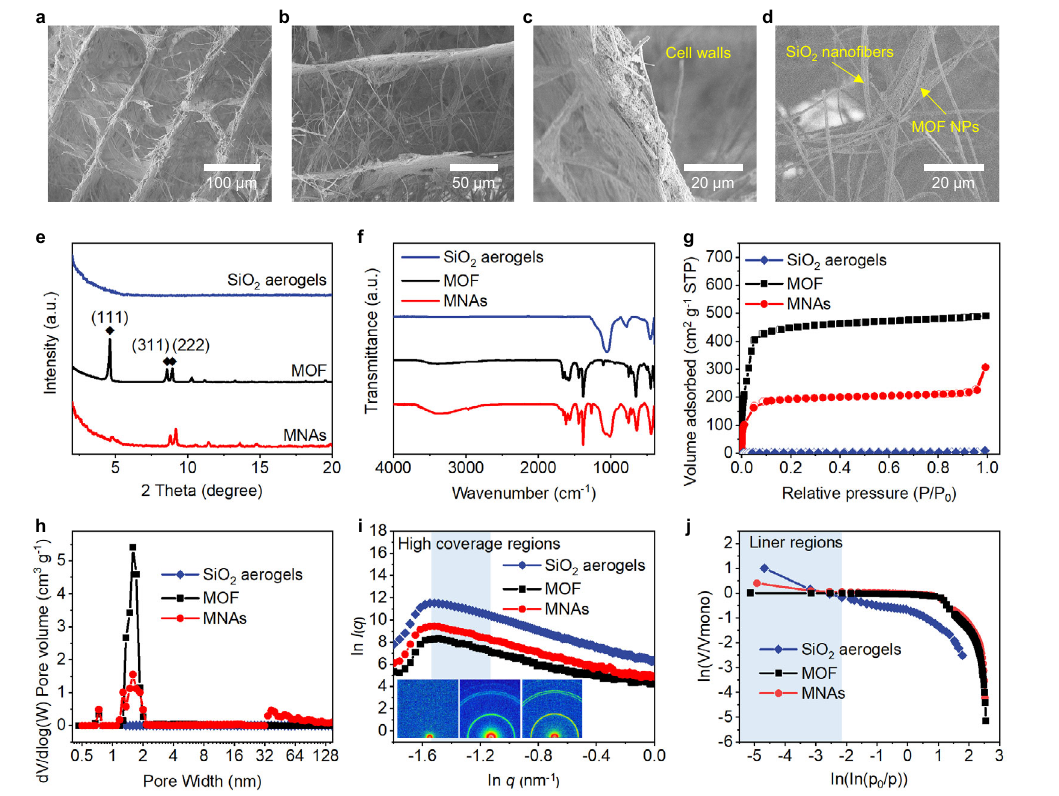
Fig. 2 | Structural characterizations of MNAs. a – d Morphologies of MNAs with lamellar MOFs/nano fi bers skeleton at various magni fi cations. e XRD, f FT-IR spec- tra, g Nitrogen adsorption-desorption isotherms, and h pore size distribution